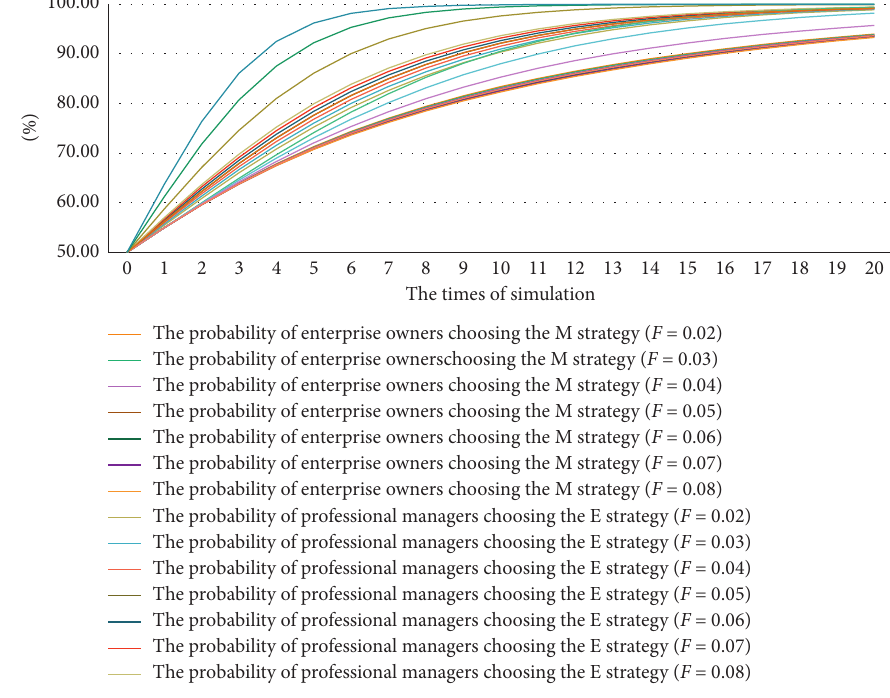
Figure 20: The impact of (F) on the evolutionary results. Table 8: The influence of variables on the strategy choices. Variables The probability of enterprise owners choosing the M strategy The probability of professional managers choosing the E strategy R m Positive